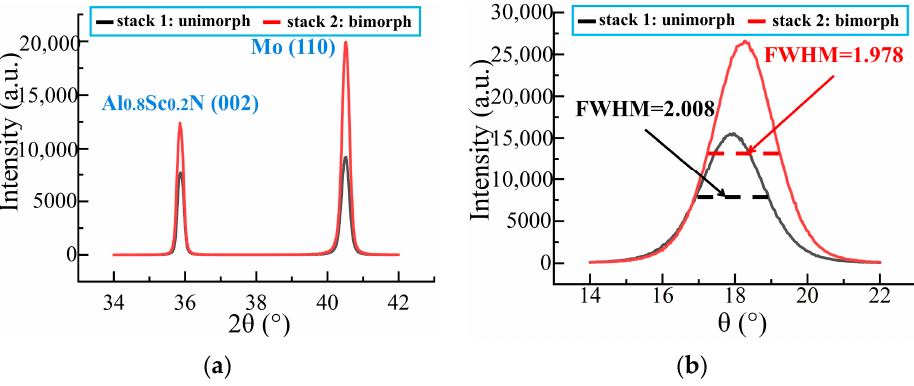
Figure 7. The fabrication results: ( a ) XRD measurement of the films stack; ( b ) Rocking curve measurement of ScAlN (002) peak.